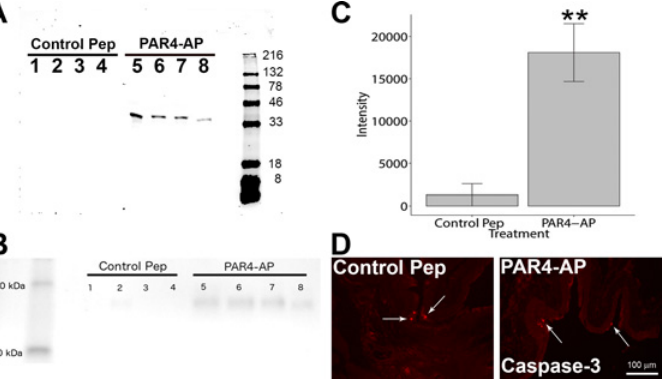
Fig 2. PAR4 activation elicits HMGB1 release in vitro and in vivo . Western blotting determined HMGB1 levels in culture media collected from human immortalized urothelial cultures (UROtsa) exposed to PAR4-AP for 2 hours (A; representative blot), and in intravesical fluid collected from mice receiving intravesical PAR4-AP for 1 hour (B). Densitometry revealed significantly more HMGB1 release from bladders receiving intravesical PAR4-AP than those receiving control peptide (C; ** p = 0.011; Wilcoxon rank test). Caspase-3 immunostaining (arrows) revealed few labeled nuclei in each treatment group